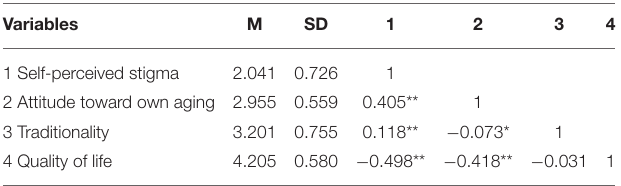
TABLE 2 | Means, standard deviation (SD), and correlations of continuous variables ( N = 764).